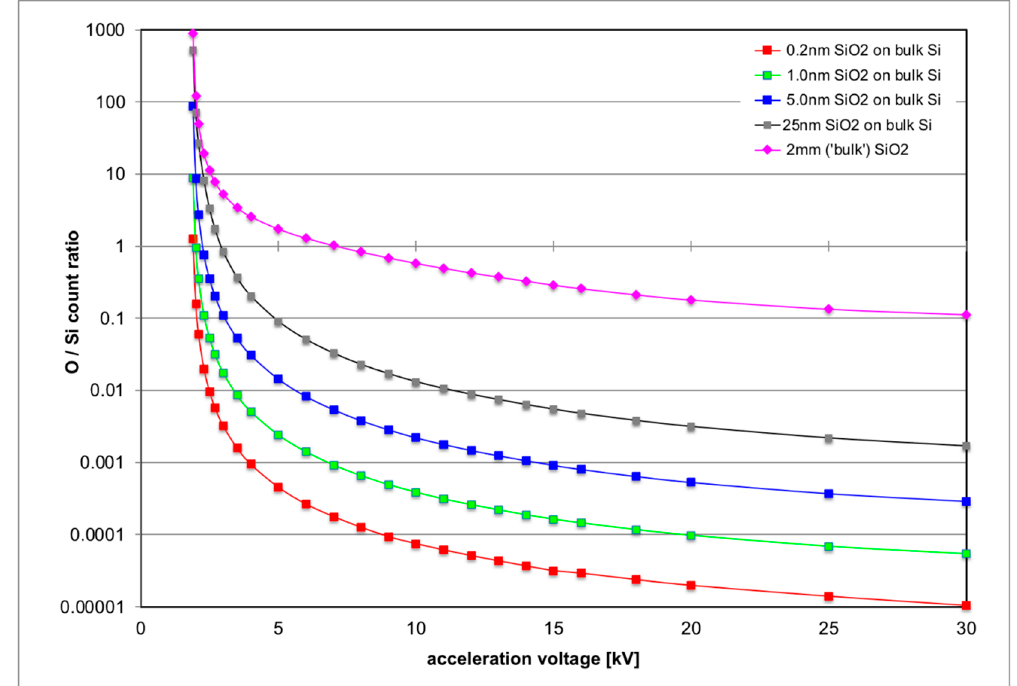
Figure 3. MC simulation of predicted O/Si X-ray count ratio vs acceleration voltage for energy-dispersive X-ray spectroscopy in a scanning electron microscope (SEM-EDXS) with standard Si detector (atmospheric thin film (SATW) polymer window, take-off angle (TOA) of 22°).